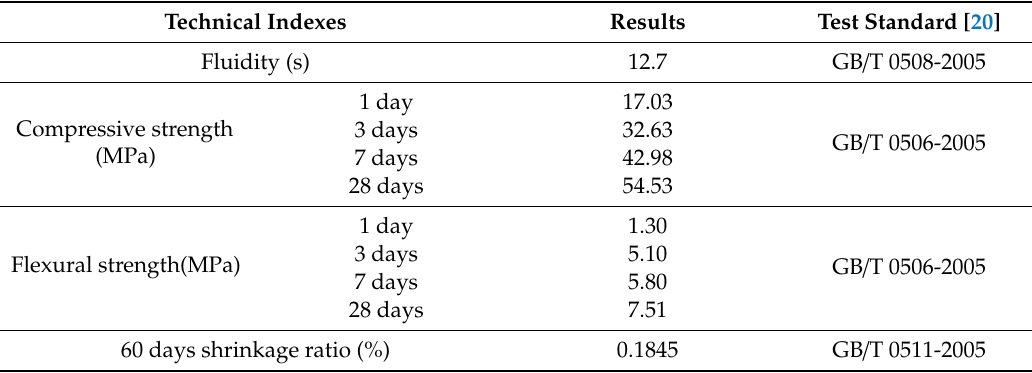
Table 1. Technical indexes of cement